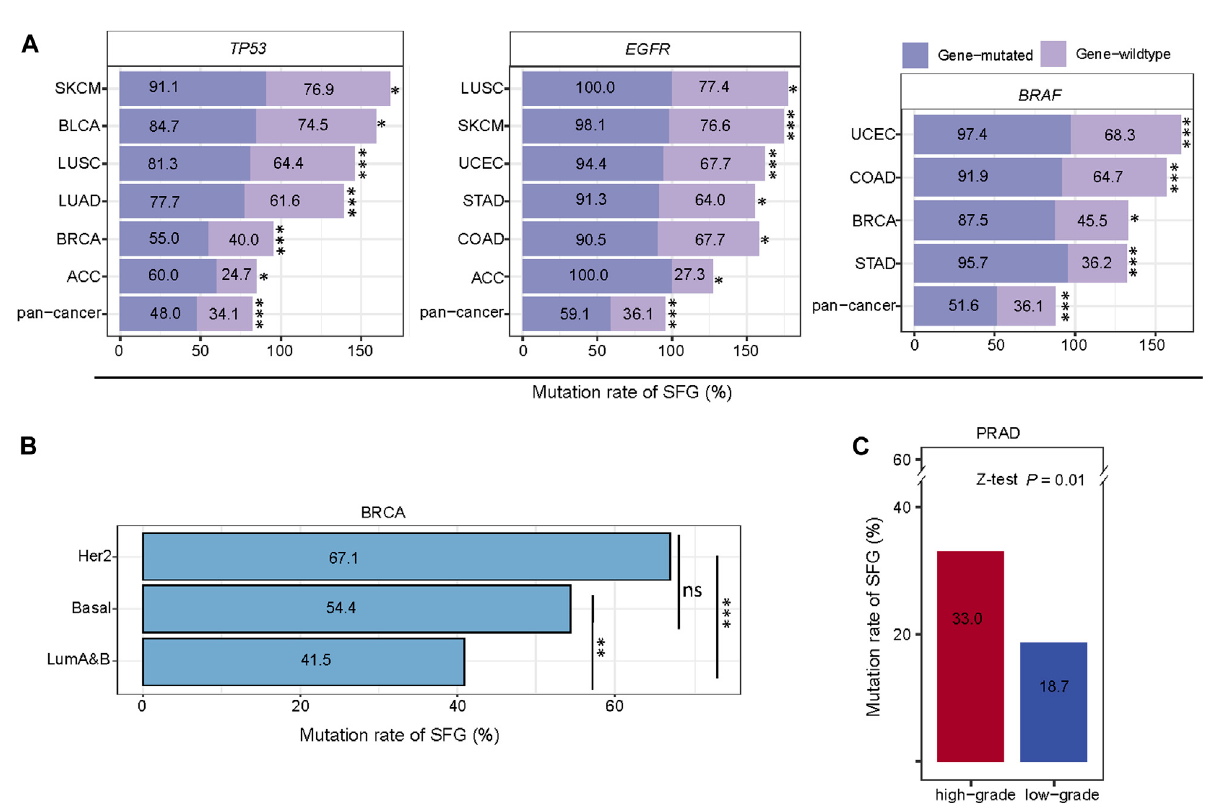
FIGURE 4 ComparisonsofmutationratesofSFGbetweendifferentcancersubtypes. (A) Thetumorswithmutationsin TP53 , EGFR ,or BRAF havesigni fi cantlyhigher mutation rates of SFG than the tumors without such mutations in pan-cancer and in multiple cancer types. (B) Comparisons of mutation rates of SFG among the breast cancer subtypes. (C) High-grade tumors (Gleason score > 7) have a signi fi cantly higher mutation rate of SFG than low-grade tumors (Gleason score < 7). * p < .05, ** p < .01, *** p < .001, ns not signi fi cant. The Z-test p values are shown in (A,B,C)